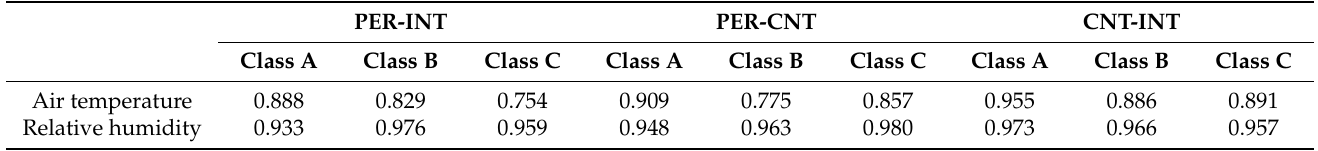
Table 5. Pearson correlation of the PER-CNT-INT zone.